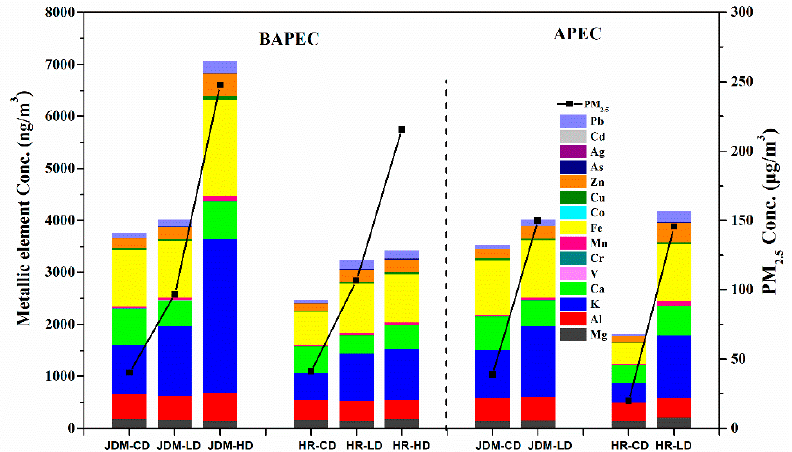
Figure 4. Concentrations of metallic elements at clean days (CD), light polluted days (LD) and heavy polluted days (HD) before and during the APEC summit in Beijing urban site (JDM) and suburban site (HR).